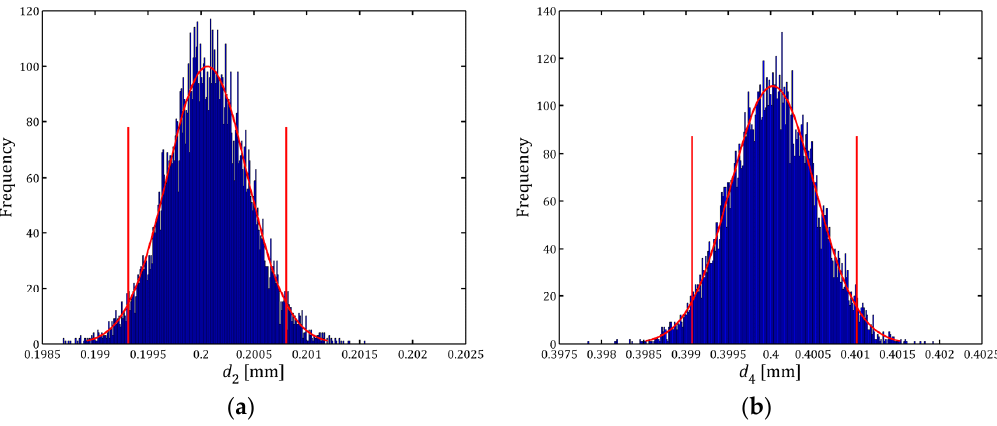
Figure 5. Hypothesis 3. ( a ) d 2 histogram; ( b ) d 4 histogram.